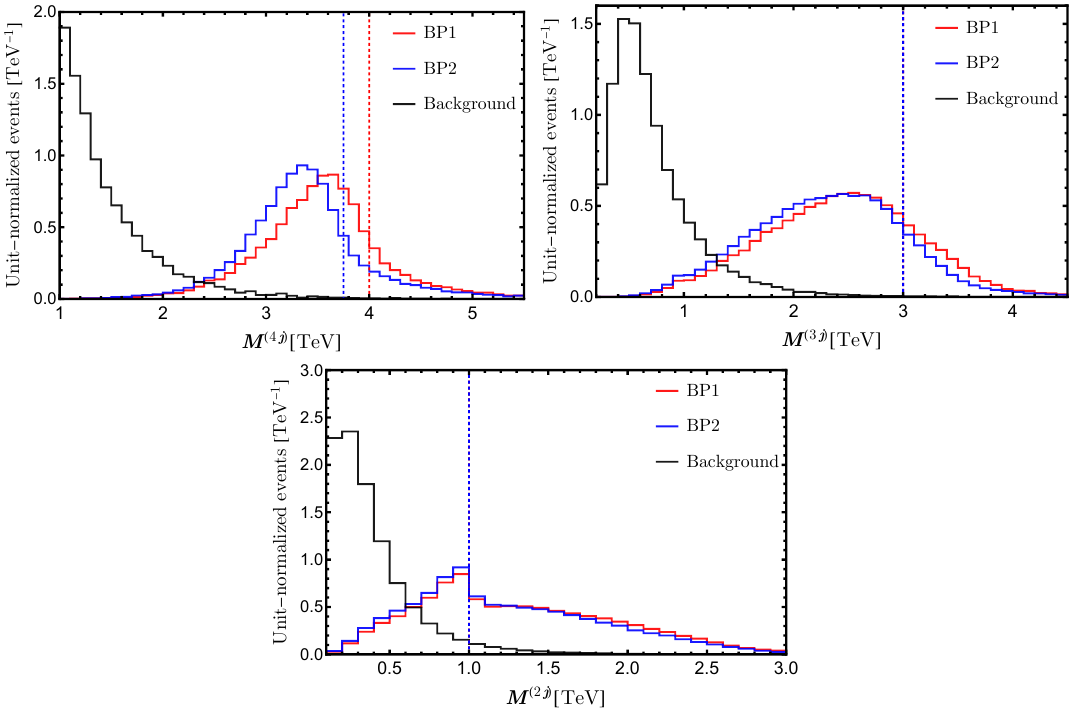
Figure 8 . Top left: Unit-normalized M (4 j ) distributions of BP1 (red) and BP2 (blue) in SR II and the QCD 4-jet background (black). The black dashed line marks the input mass of KK graviton while our 4-jet invariant mass window cuts are indicated by red dashed lines and blue dashed lines for BP1 and BP2, respectively. Top right: Unit-normalized M (3 j ) distributions of BP1 (red), BP2 (blue), and the background (black). The black dashed line marks the input mass of KK gluon while our trijet invariant mass window cuts are indicated by red dashed lines and blue dashed lines. Bottom: Unit-normalized M (2 j ) distribution of BP1 (red), BP2 (blue), and the background